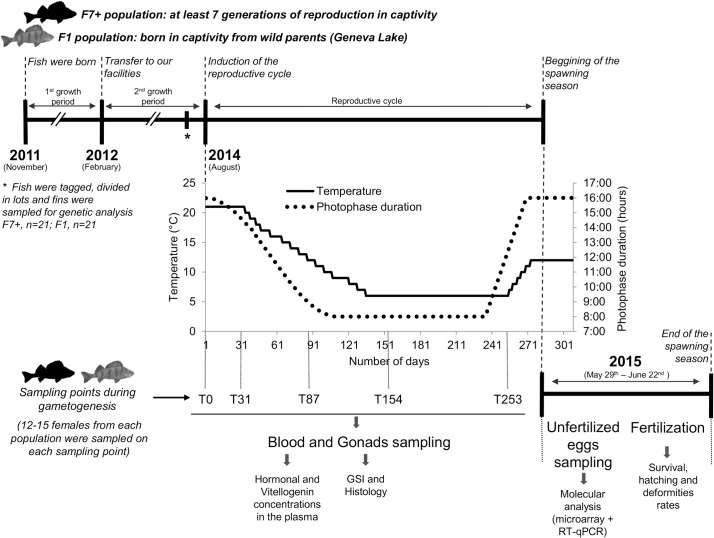
Graphic summary of the experimental design.The photothermal program was used to control each step of the reproductive cycle and spawning of Eurasian perch. Fish sampling was performed at T0, T31, T87, T154 and T253 days after the beginning of the photophase initial decrease (induction of the reproductive cycle). For each sampling point, sexual steroids and Vitellogenin levels were measured in the plasma and a histological follow up of the oogenesis progression was performed. During spawning, each spawn was split into two parts. The first one was not fertilized and frozen for further molecular analyses while the other part was fertilized to assess the developmental progression. All details are given in the method paragraph.